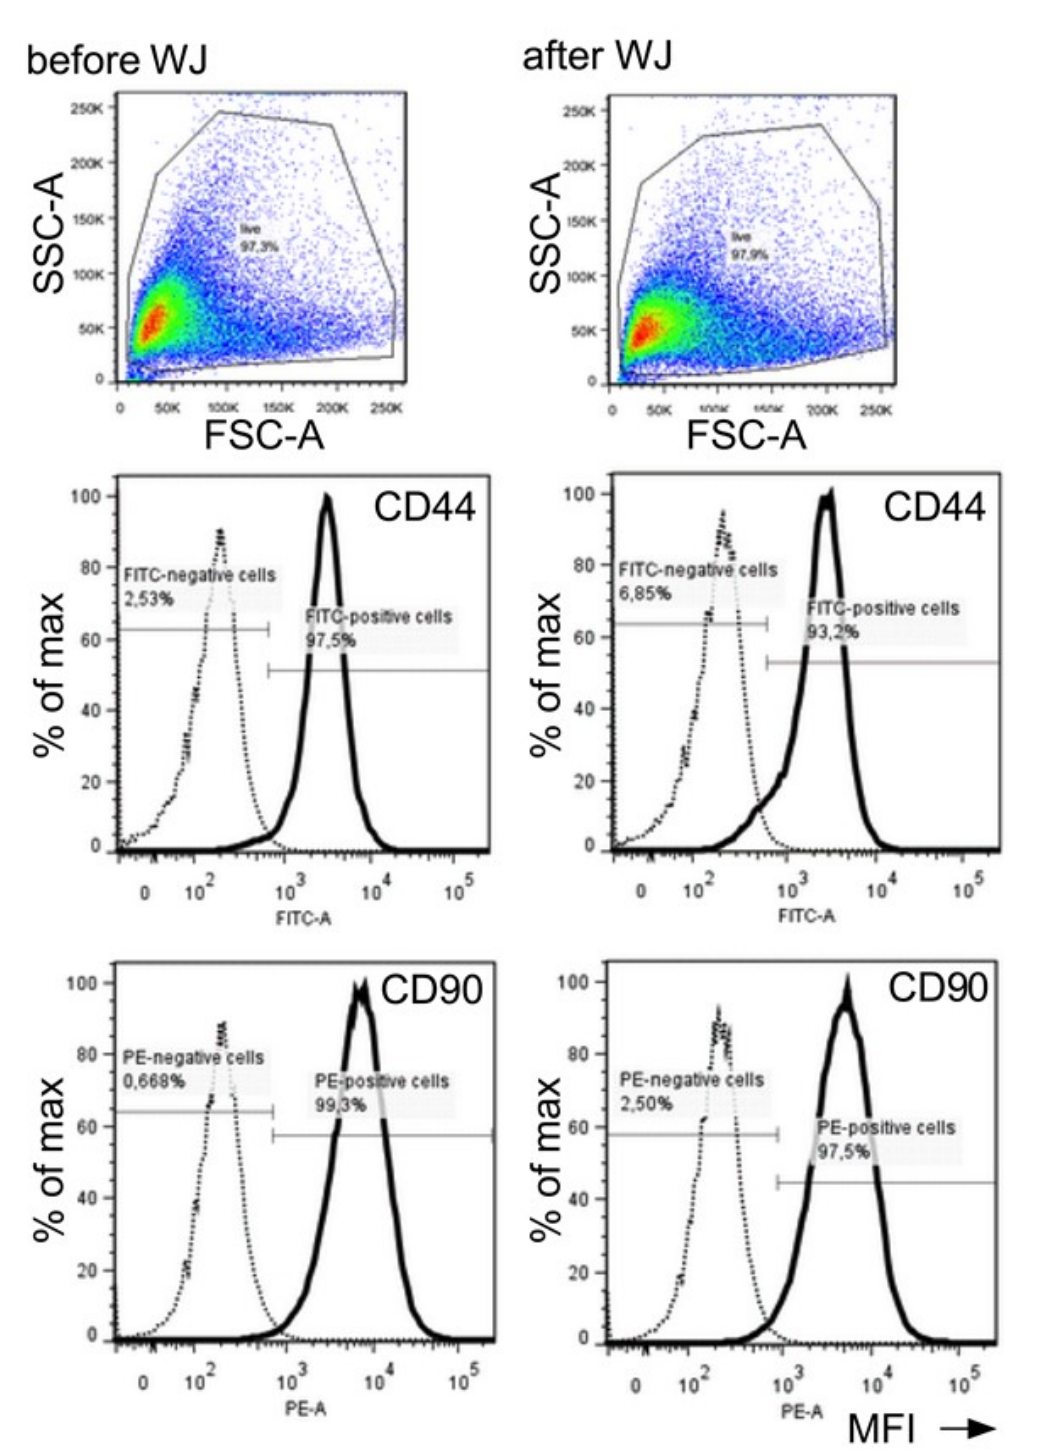
Figure 8. Detection of cell surface markers after WJ injection. Flow cytometry was employed to analyze the effect of WJ injections on pADSCs surface markers. Changes in cell size (forward light scatter; FSC-A), granularity and roughness of the cells (side light scatter, SSC-A), and the expression of mesenchymal markers CD44 and CD90 were determined. The numbers of cells expressing CD44 and CD90 are presented as a percentage (%) of the maximum (Y-axis) and their mean fluorescence intensities (MFI, X-axis). Major differences in cells markers prior to (left panels) versus after WJ injections (right panels) were not observed. Abbreviations: WJ—waterjet.